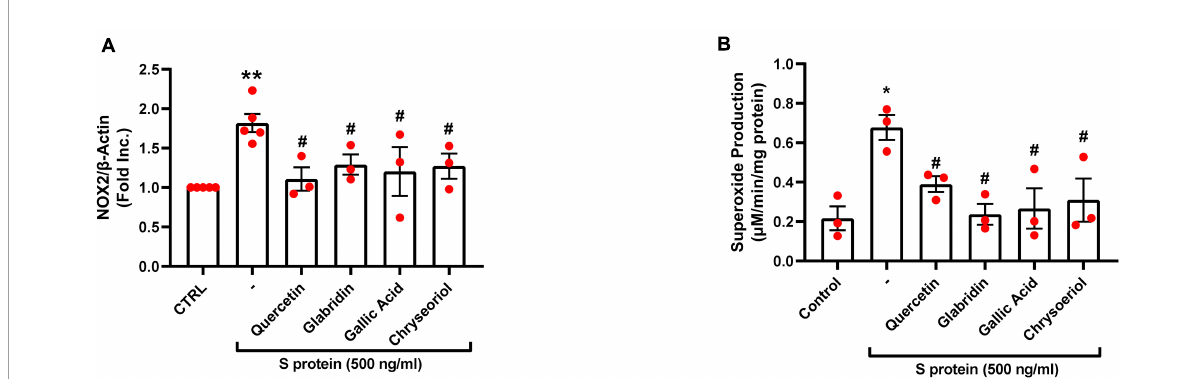
FIGURE4 Attenuation of SARS-CoV-2 spike protein-induced upregulation of NOX2 and excessive superoxide production by quercetin, glabridin, gallic acid, and chrysoeriol. Bovine aortic endothelial cells (BAECs) were pretreated with viral spike protein (S protein, 500 ng/ml) for 30 min before exposure to 100 nmol/l of small molecule compounds for 24 h. (A) Grouped data of NOX2 protein expression indicating upregulation of NOX2 by S protein, which was near completely attenuated by small molecules. n = 3–5. (B) Grouped data of superoxide production as determined specifically and quantitatively by electron spin resonance (ESR), indicating S protein induction of excessive superoxide production in endothelial cells, which was near completely alleviated by small molecules. Data are shown as mean ± SEM. n = 3, ** p < 0.01 vs. control group; # p < 0.05 vs. S protein treated group by one-way ANOVA.